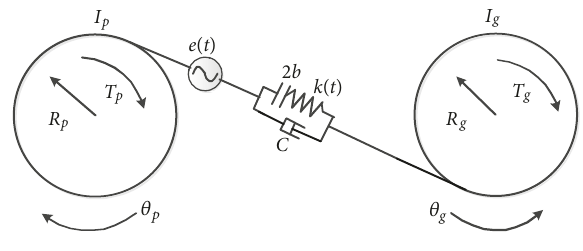
Figure 1: The gear transmission